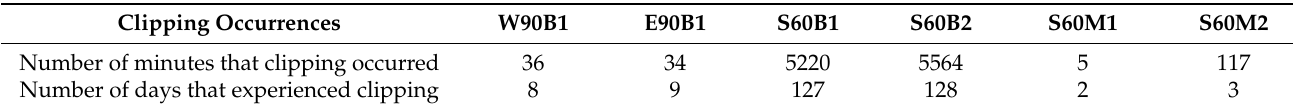
Table 3. The total number of minutes during which clipping was suspected of occurring for each module as well as the number of days that clipping occurred during the study period. For reference, the data set used in this analysis included 408 days and 587,524 min of data.